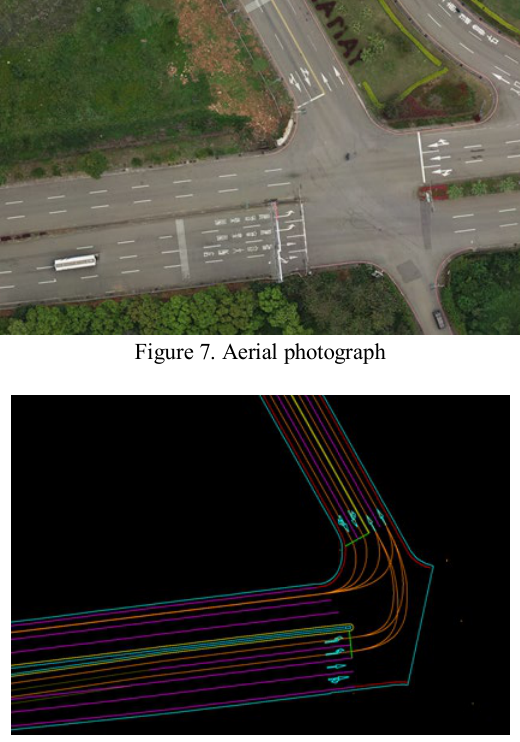
Figure 8. Polylines and polygons extracted (a) Lane edge (b) Center